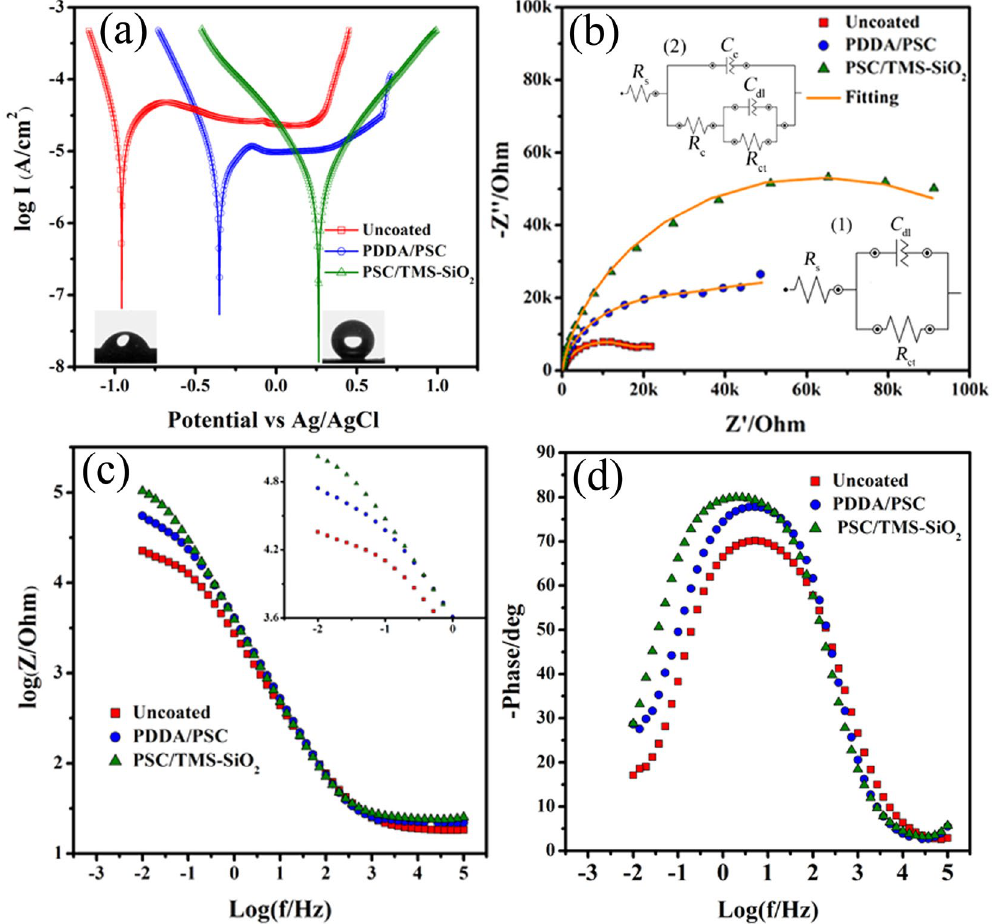
Figure 7. Potentiodynamic polarization curves of ( a ) uncoated, PDDA/PSC and PSC/TMS-SiO 2 coating with their respective CA images as inset. ( b ) Nyquist plot of uncoated and coated samples, equivalent circuits used to fit the EIS diagrams of (b1) uncoated and (b2) coated samples. ( c ) Bode impedance and ( d ) phase plot of uncoated and coated samples.